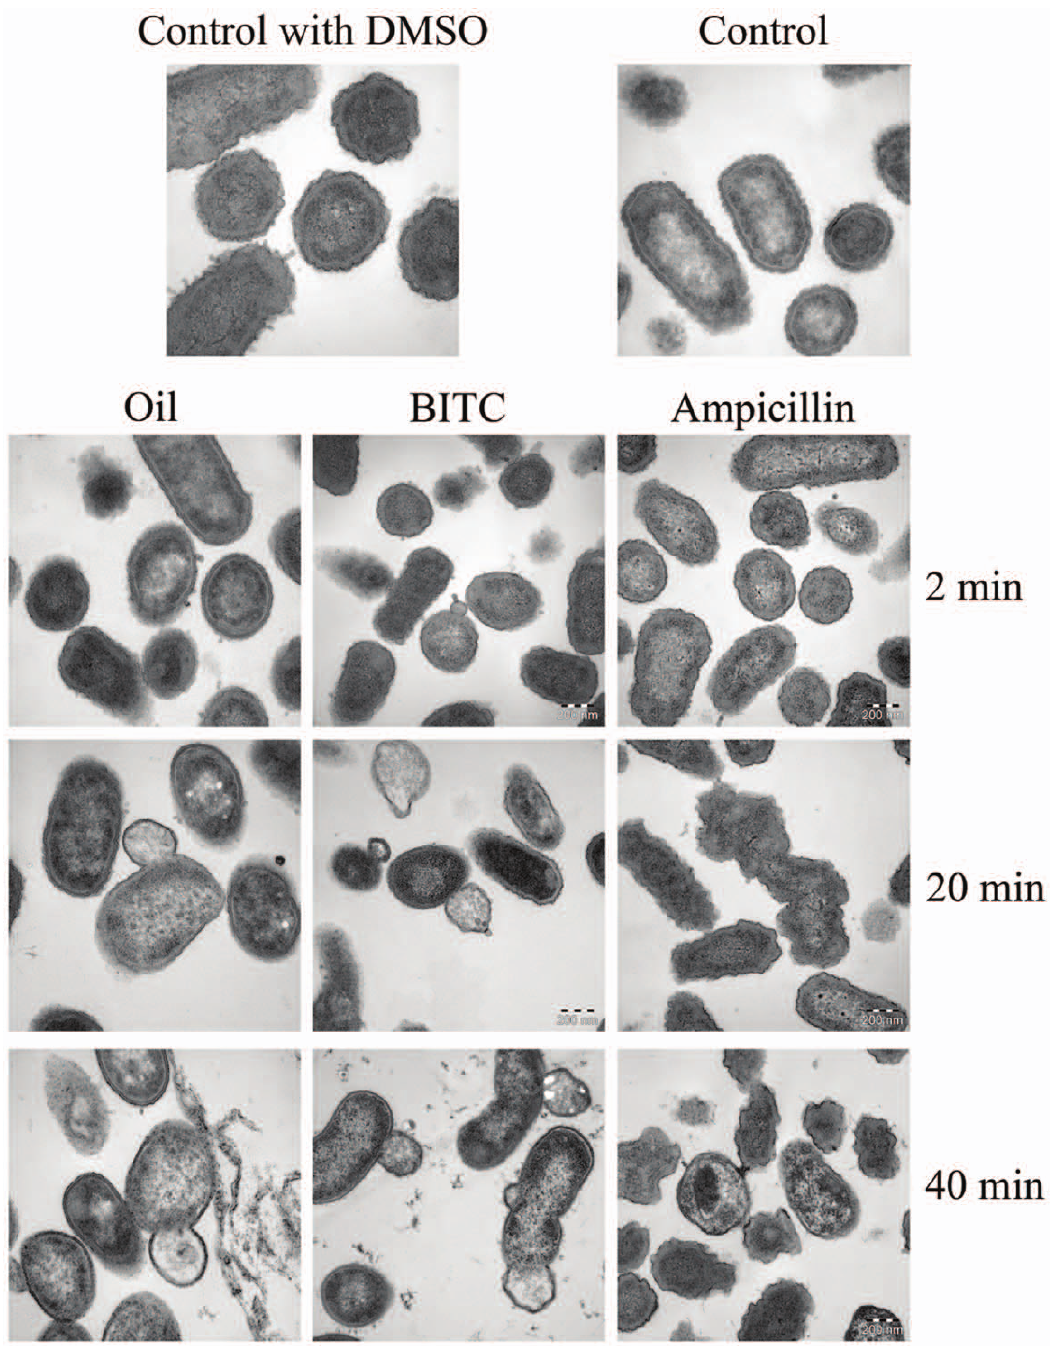
Figure 5. Transmission electron micrographs of A.actinomycetemcomitans treated with essential oil, BITC or the antibiotic ampicillin. Samples were withdrawn at time points indicated. Concentration of essential oil was 0.1%, which corresponds to a content of 2.8 m mole BITC. The amount added synthetic BITC was 2.8 m mole and ampicillin concentration was 1 mg/ml. Control for essential oil and BITC contained 1% DMSO. For ampicillin, the control was with 1% water. The control bacteria were withdrawn after 40 min of